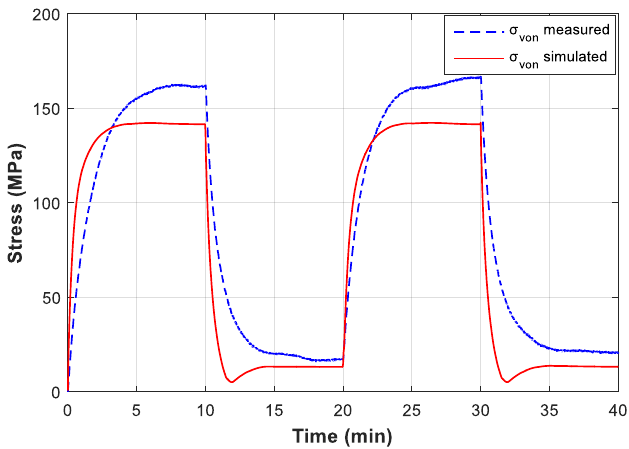
Figure 18. Comparison of the von-Mises stress obtained from the simulation and measurement.